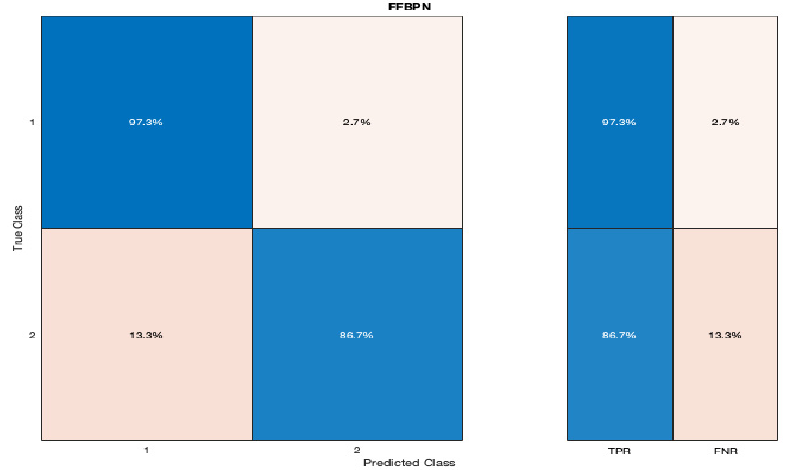
Figure 3. Graphic representation of the confusion matrix with the true positive rates (TPR) and false negative rates (FNR) for the prediction of SGA newborns (listed here as 2) when using a Feed-Forward Back Propagation Network (FFBPN).